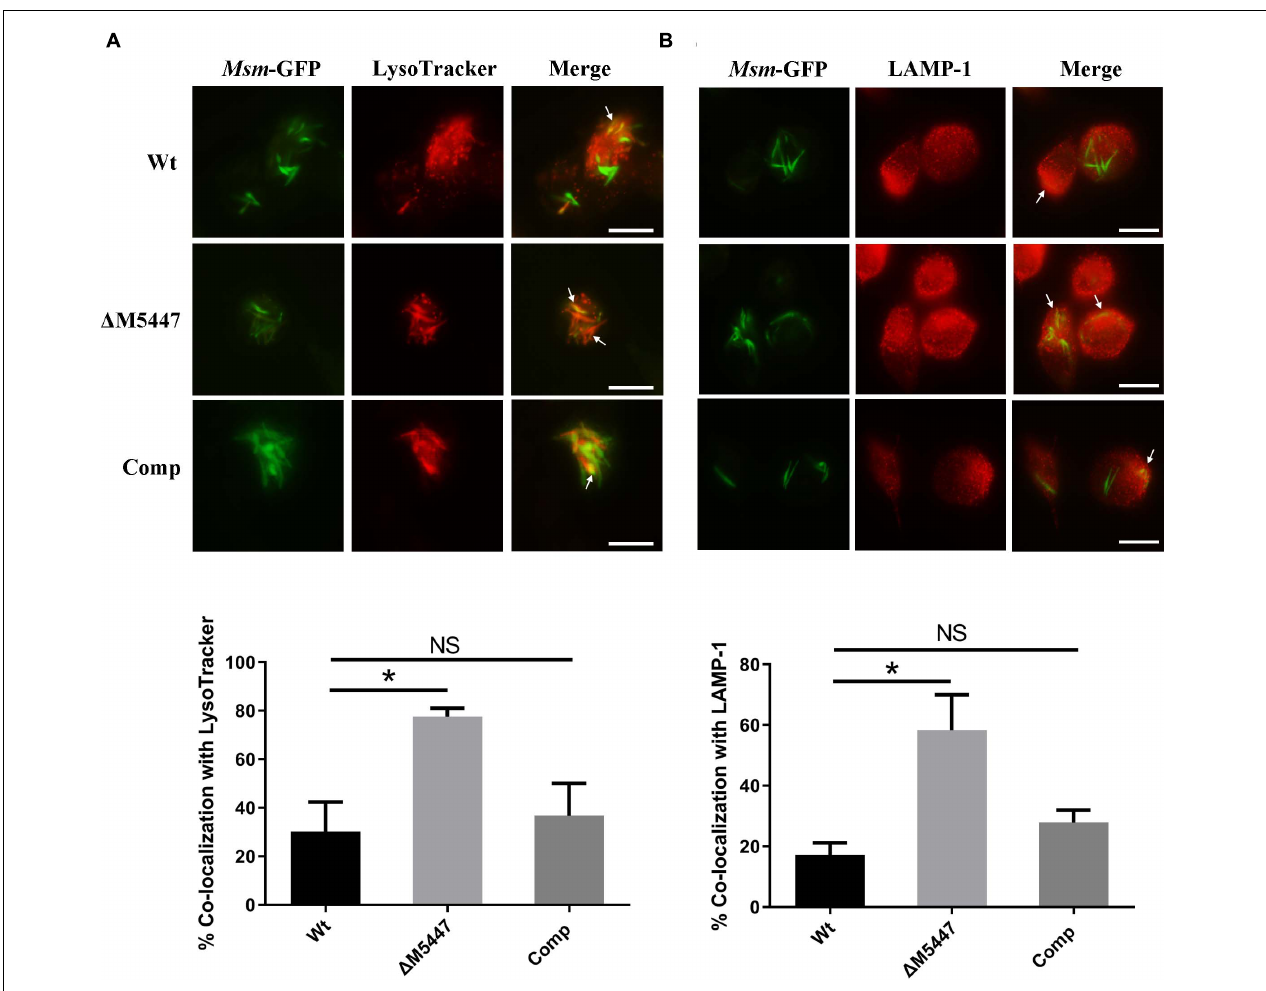
FIGURE 7 | (cid:49) M5447 stain failed to arrest the phagosome–lysosome fusion in infected macrophages. THP-1 macrophages were infected with green fluorescence protein (GFP)-expressing Wt, (cid:49) M5447, and Comp strains for 3 h at an MOI of 10. After 24 h of infection, cells were stained with LysoTracker Red for 30 min before fixation (A) or incubated with a LAMP-1 antibody (B) . The cells were visualized by fluorescence microscopy. The yellow color represented the co-localization of green and red fluorescence, as shown in images. The white arrows indicate the co-localization of green and red fluorescence. Scale bars, 25 µ m. Quantitation of co-localization was shown as mean ± SD in at least 100 random infected cells. NS, there was no statistically significant difference between groups. Statistical analyses were performed by the method of two-tailed t -test (* p <